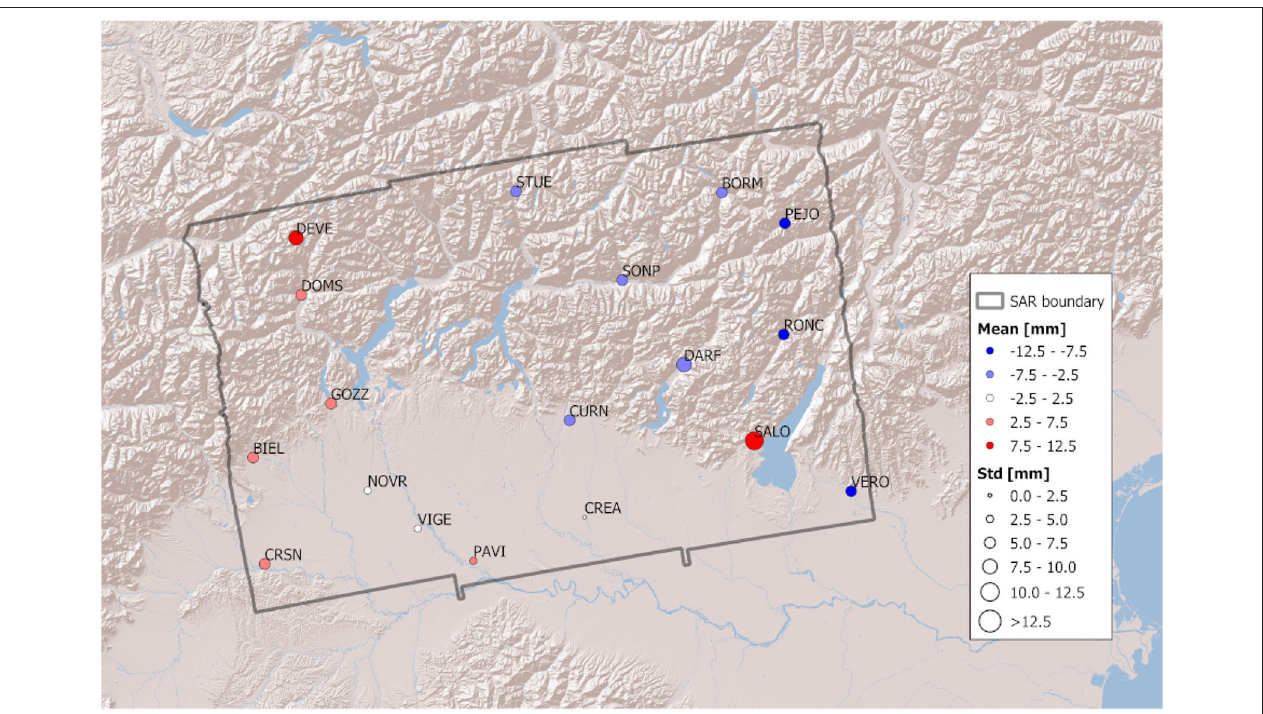
FIGURE 5 | Map of the temporal statistics of the difference between GNSS 1 ZTD values and SAR 1 ZTD